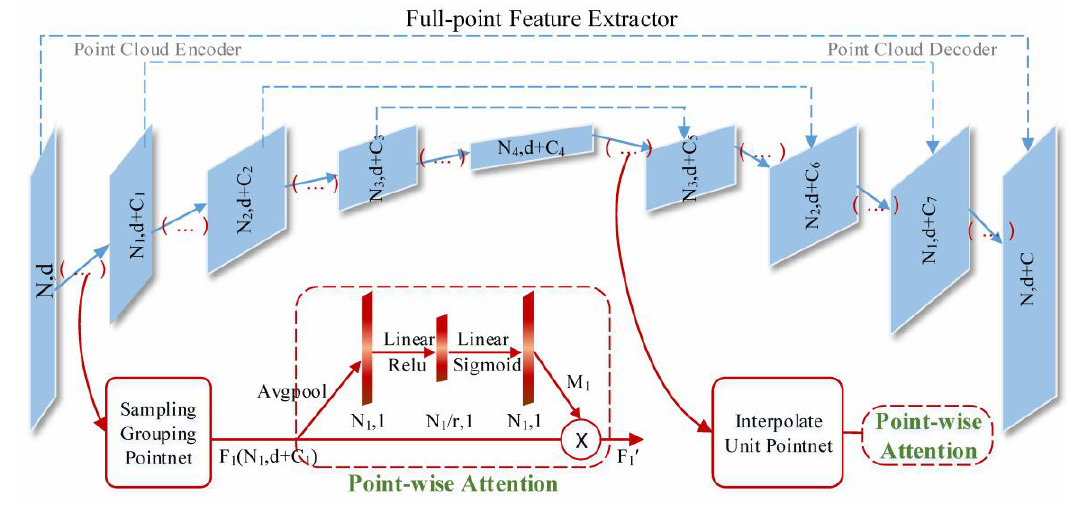
Figure 2. Architecture of our full-point feature extractor with the proposed point-wise attention (PA) modules.